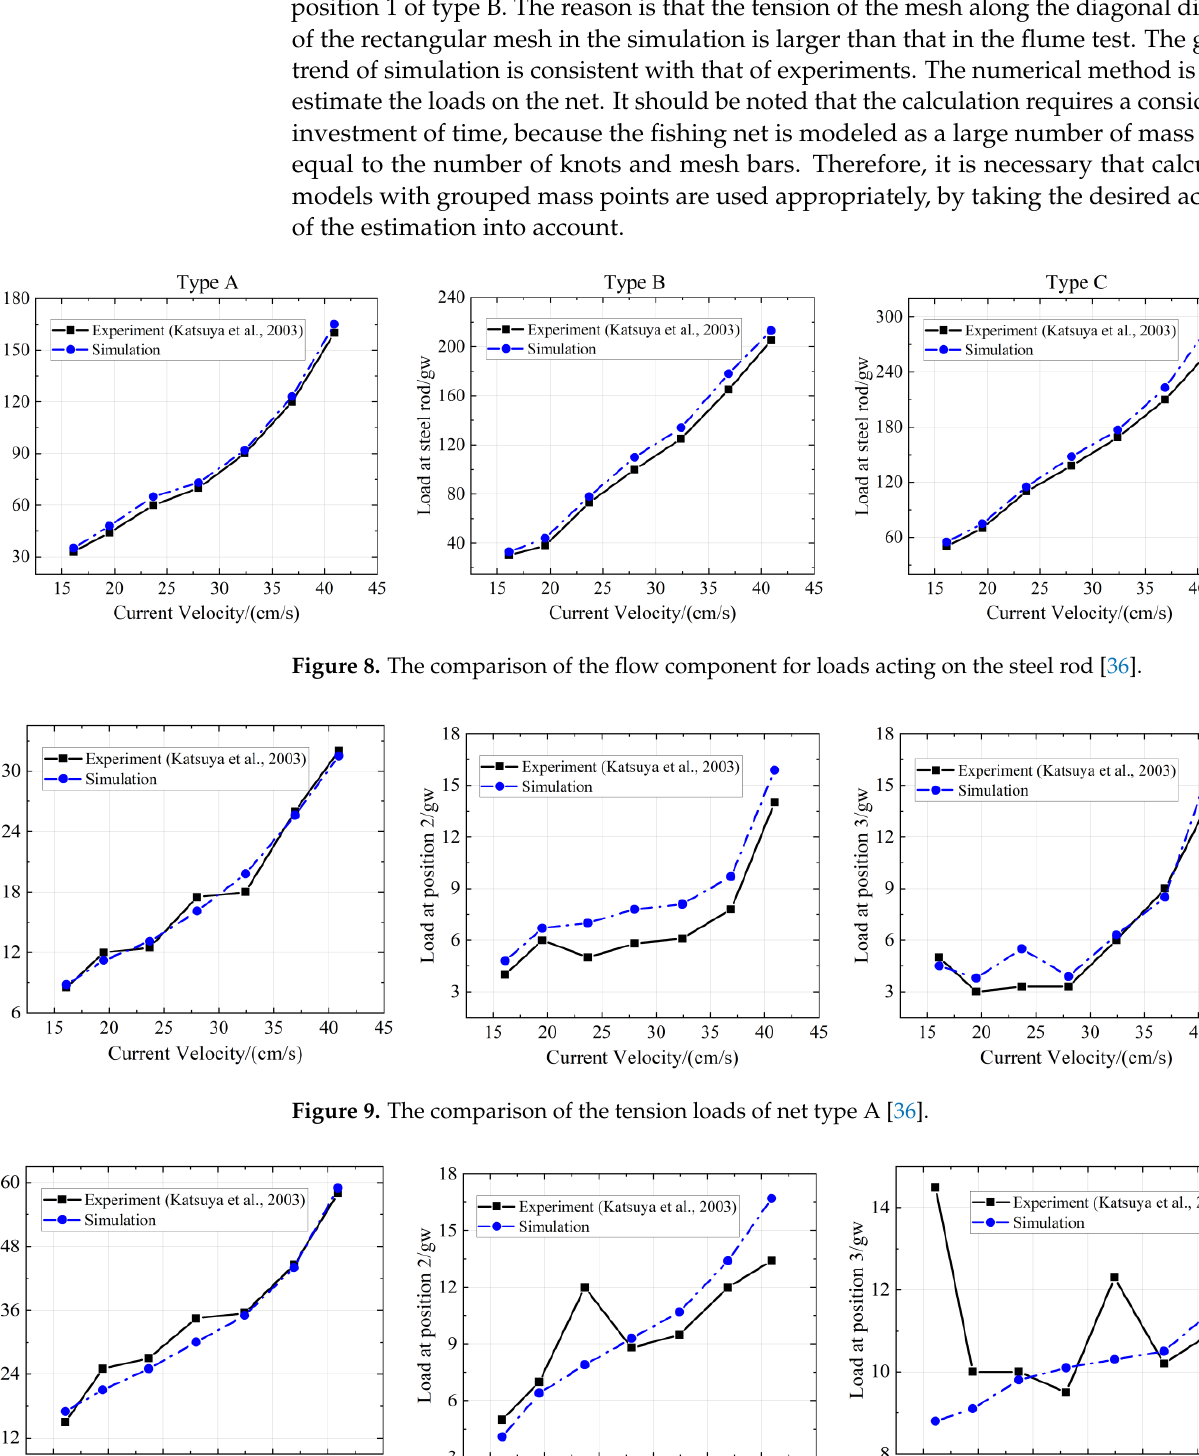
Figure 7. The diagram of the validation model.